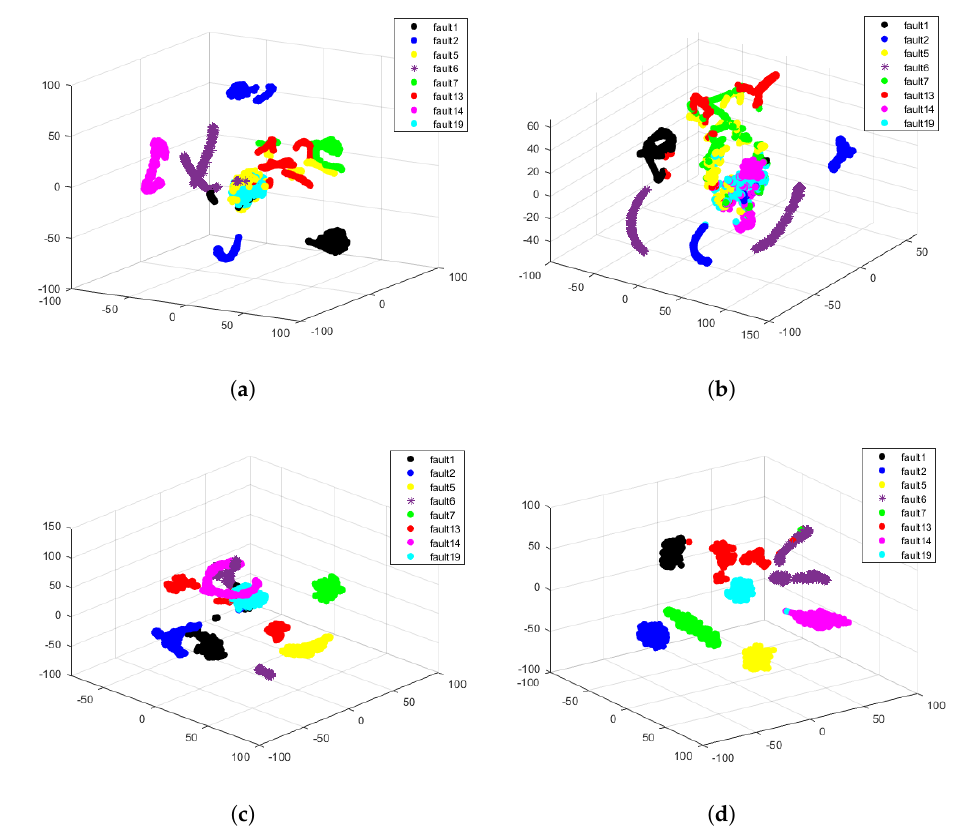
Figure 9. Comparison of t–SNE visualization results of fault features: ( a ) Visualization results of PCA extracted features; ( b ) Visualization results of GLPP extracted features; ( c ) Visualization results of SAE extracted features; ( d ) Visualization results of DESAE extracted